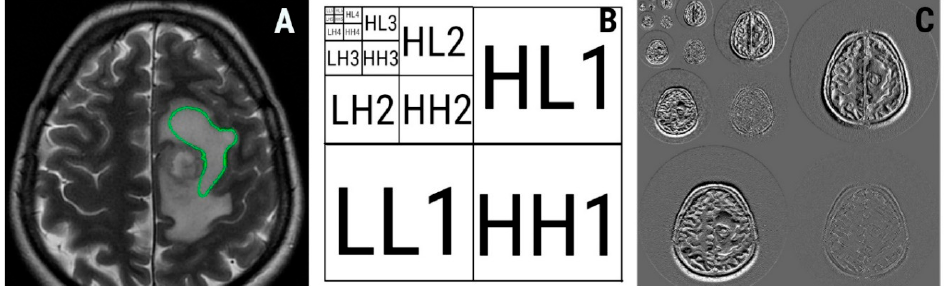
Figure 5. Axial T2-weighted image of a 72-year-old patient with glioblastoma ( A ) and the region of interest (green) used for texture analysis; ( B ) five-level wavelet decomposition diagram; ( C ) five-level wavelet decomposition of ( A ). The numbers represent the decomposition levels. Frequency bands are noted: LL, low–low; HL, high–low; LH, low–high; HH, high–high.